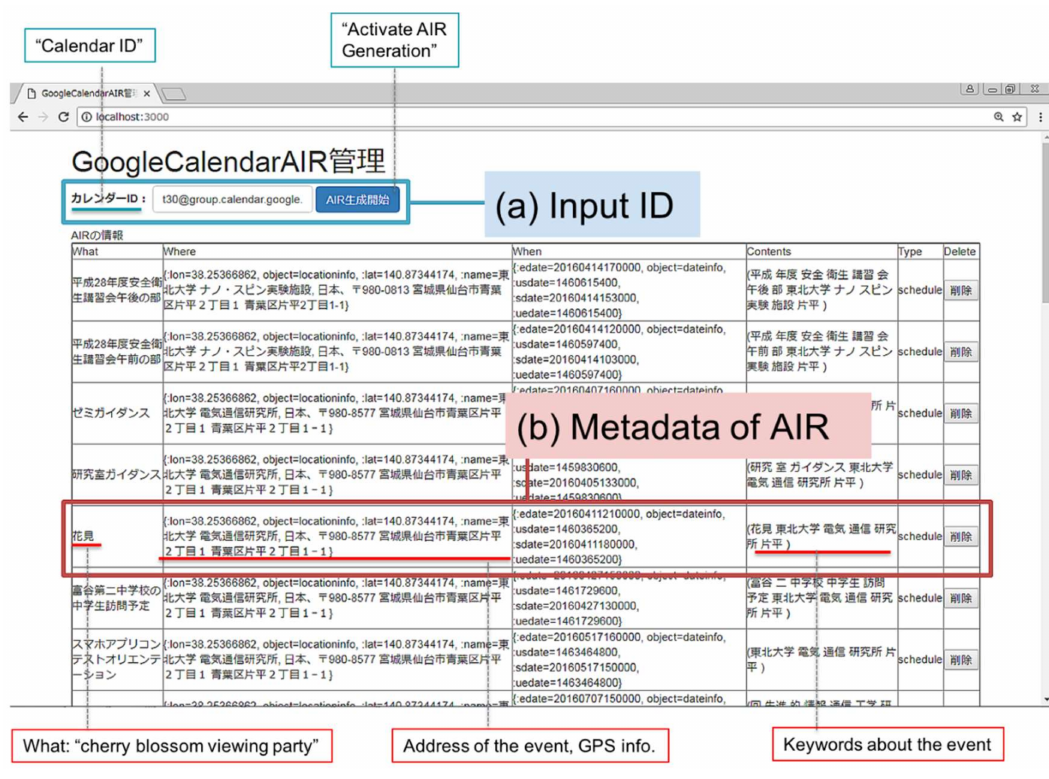
Figure 8. AIR management